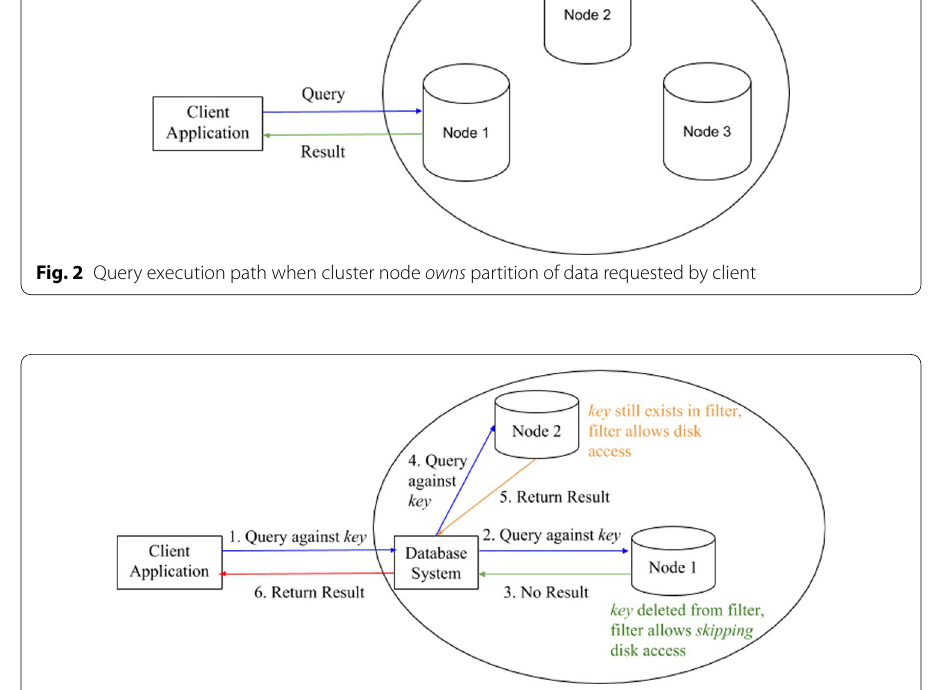
Fig. 3 Failure of Database System to infer correct result with our proposed scheme applied, in the case where Consistency Level requirement > 1